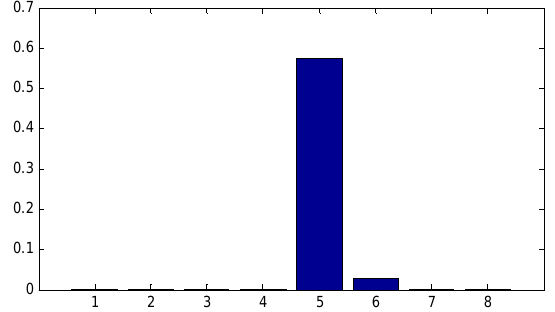
Figure 15. The distribution of the frequency band energy on the ensemble multiwavelet transform coefficients in the assembled quality condition 2.